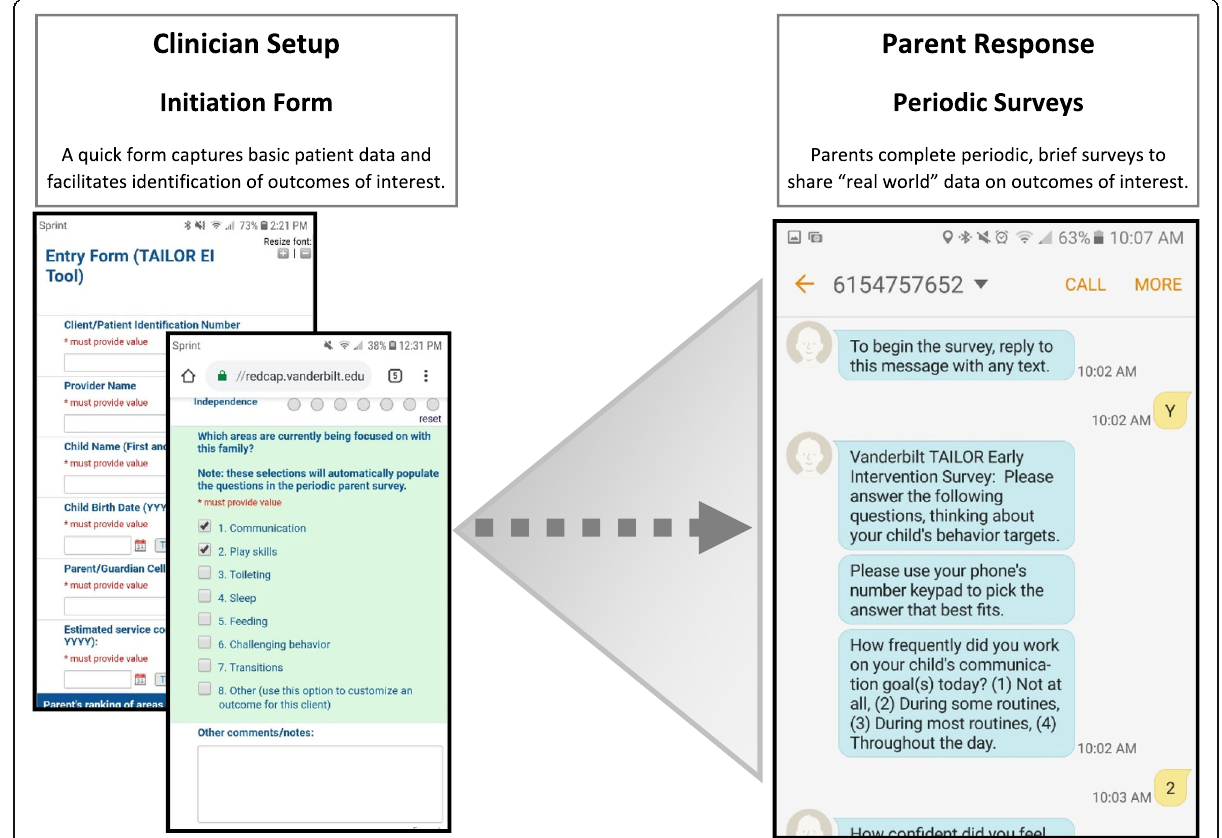
Fig. 1 TAILOR examples: initiation/set-up form and data exchange by text